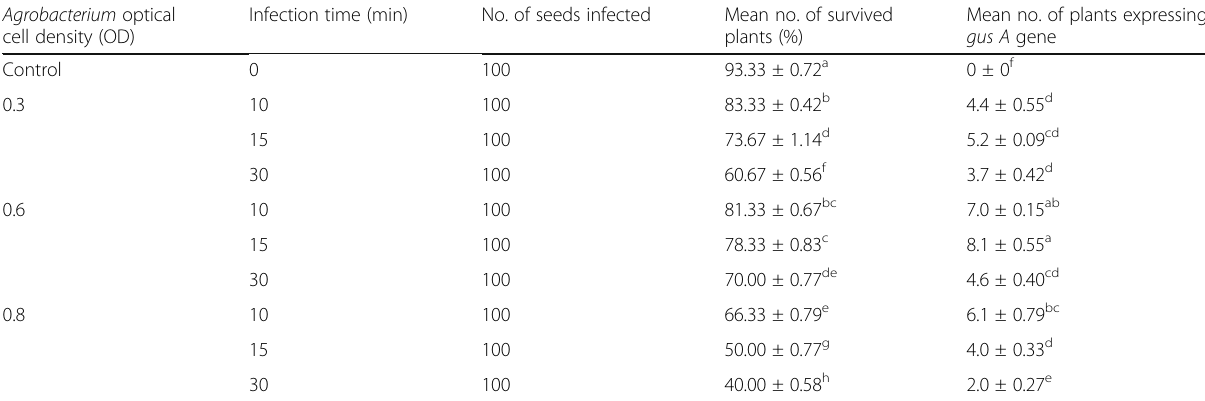
Table 1 Effects of different Agrobacterium culture densities and infection period on the survival rate and gus A gene expression in horse gram plants